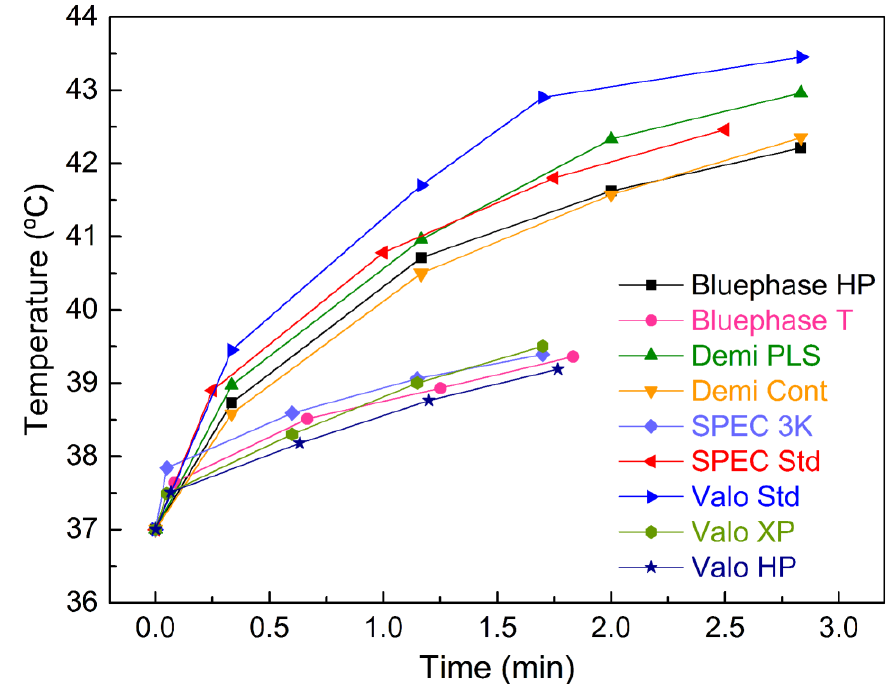
Figure 2. Mean pulp temperature values after each period of light exposure for all LED LCUs and exposure modes.